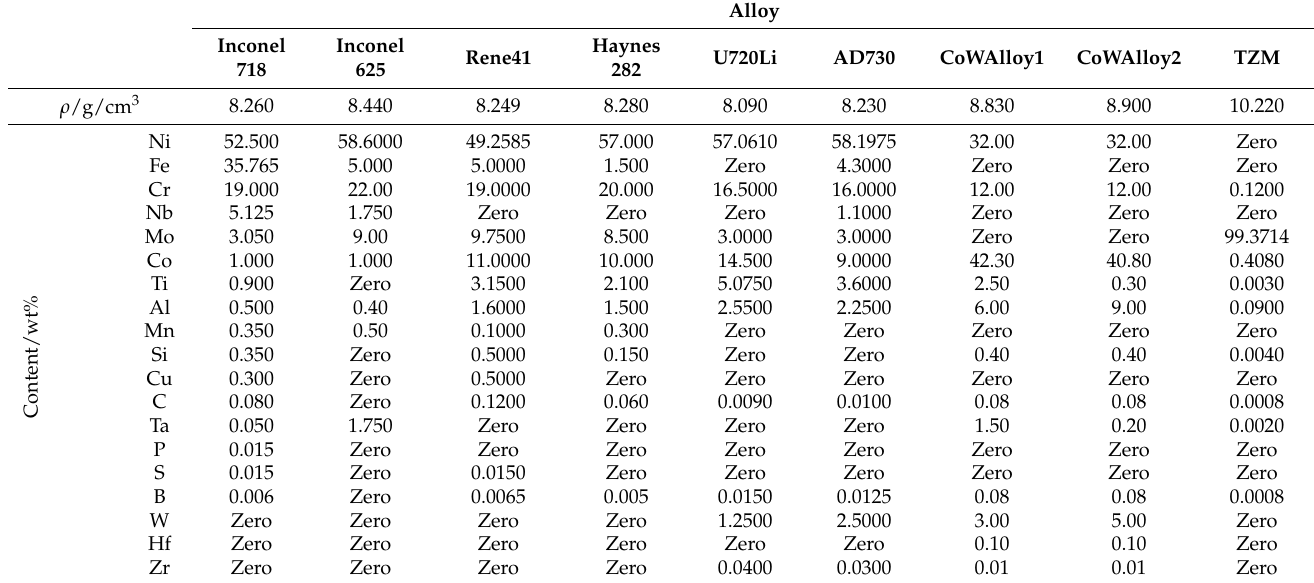
Table 1. Compositions and density ρ of alloys used for calculations of X-ray transmission.